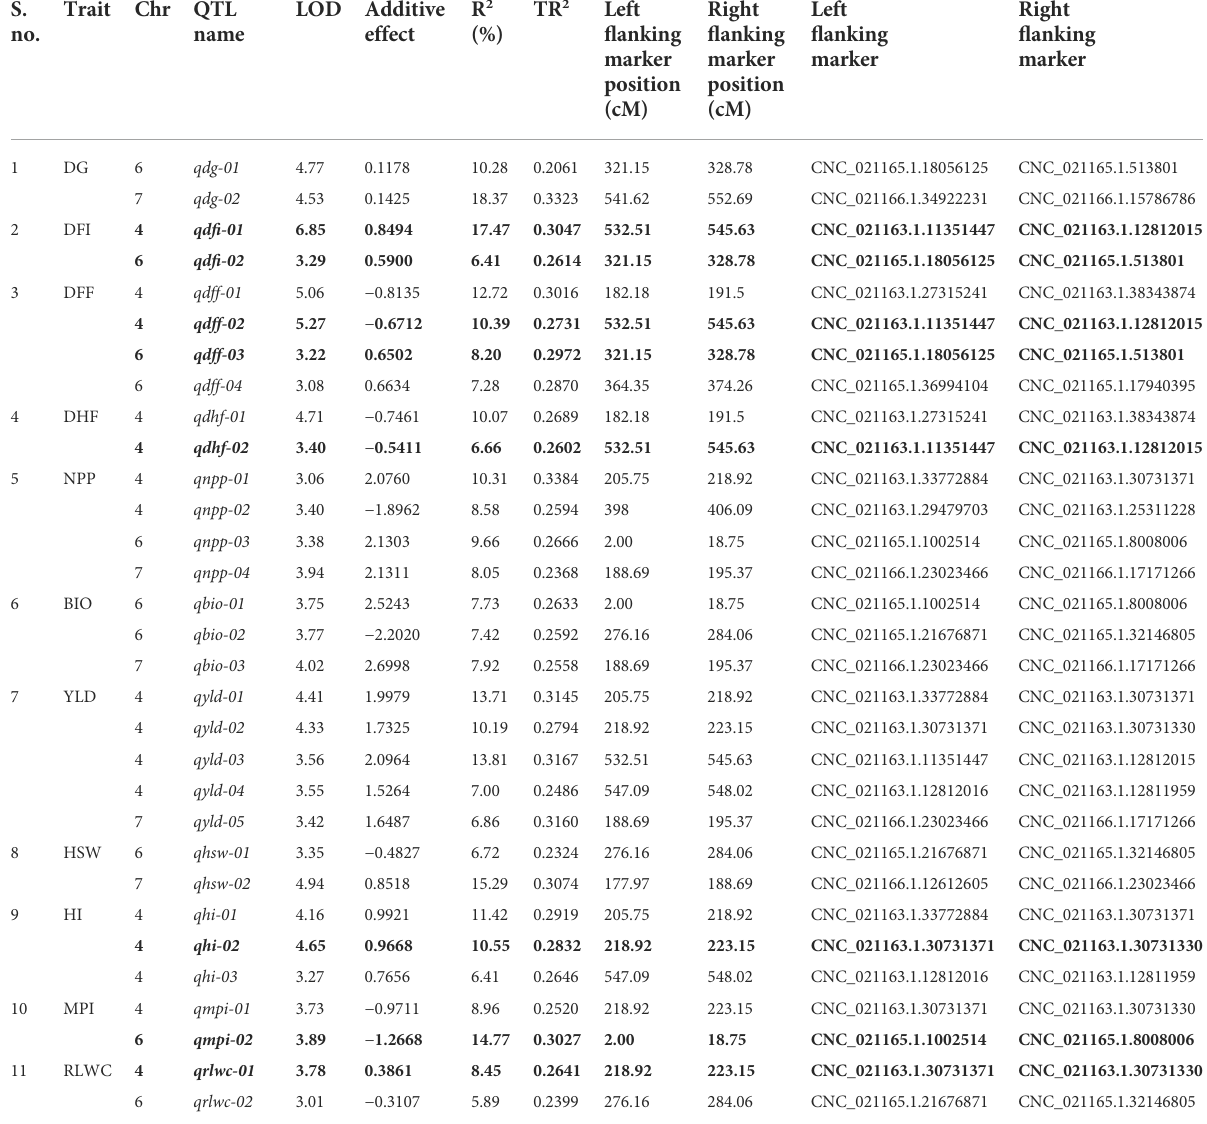
TABLE 5 Summary of QTLs associated various morphological and physiological traits evaluated at Ludhiana. S. Trait Chr QTL no.